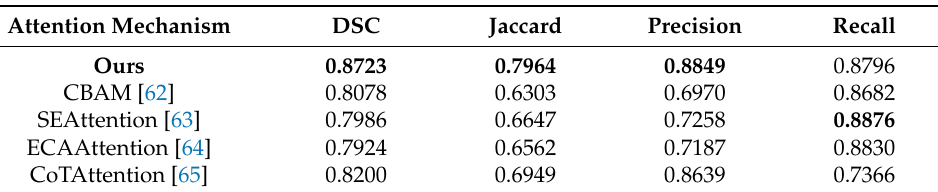
Table 3. Segmentation performance of the model fusing different attention mechanisms. Except for the replacement of the attention mechanism, the rest of the model and the parameter settings are identical to CAFS. The adaptive attention mechanism achieves the highest values on all three metrics: DSC, Jaccard, and Precision, indicating its superior feature extraction performance.